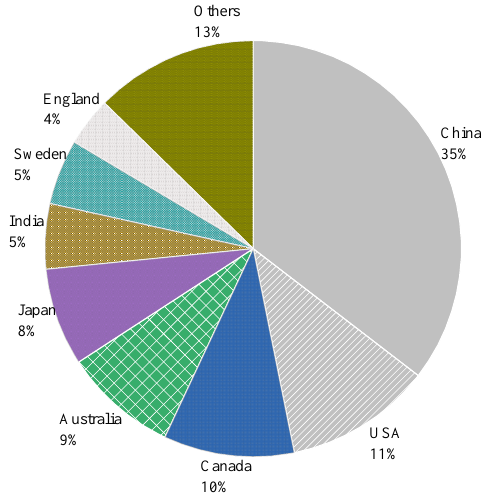
Figure 5. Geographical distribution of publications.